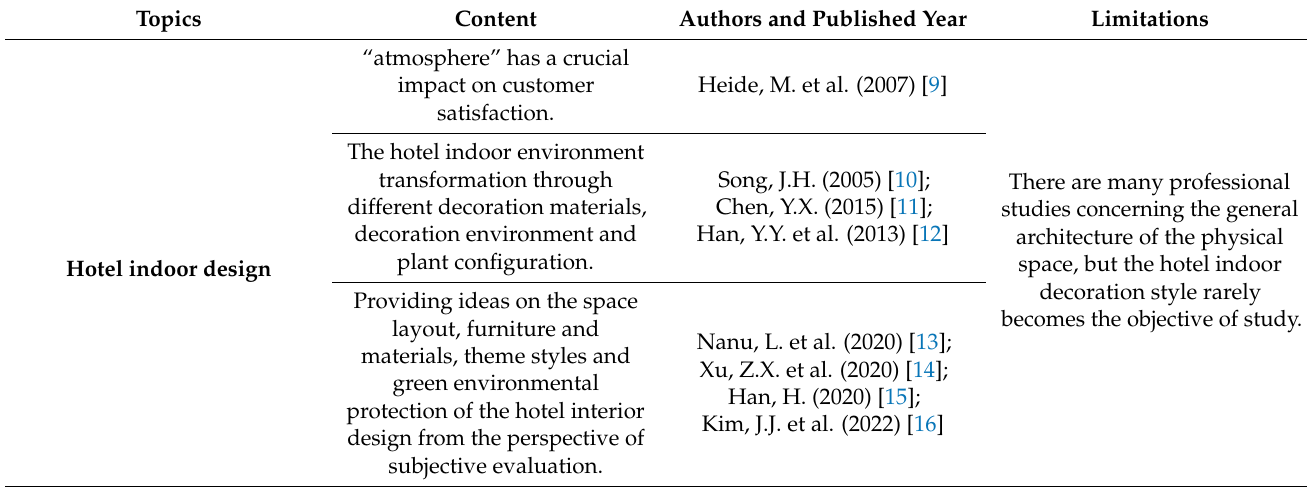
Table 1. Literature review